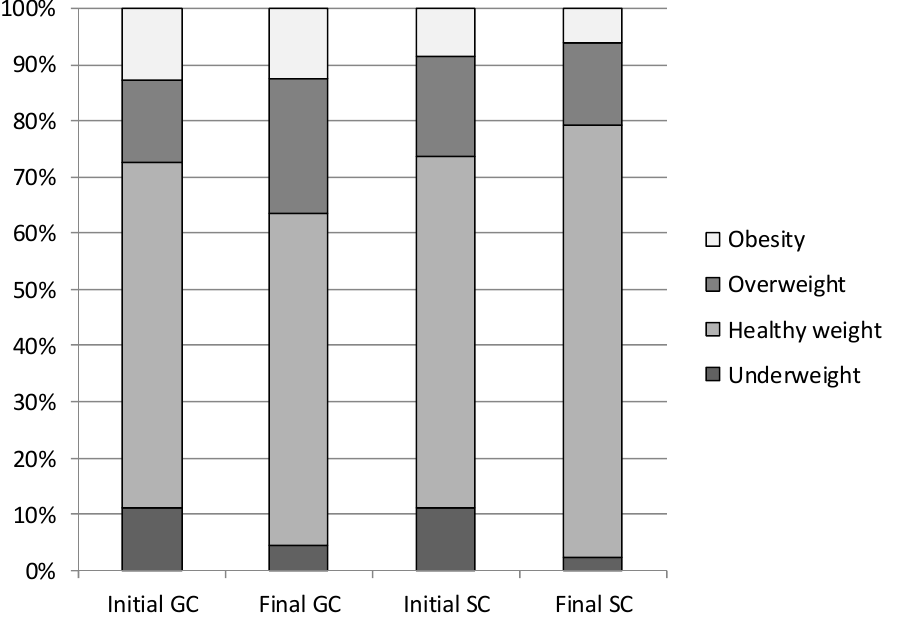
Figure 6. Percentage of GC and SC boys in particular body fat content categories—comparison between initial and final measurement session. Initial—initial measurement session; Final—final measurement session; GC—general education classes (standard PA, 4 h a week); SC—sport classes (elevated PA, 10 h).